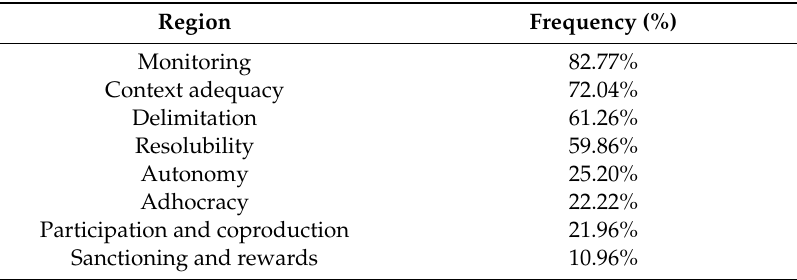
Table 7. Dimensions and frequency of positive